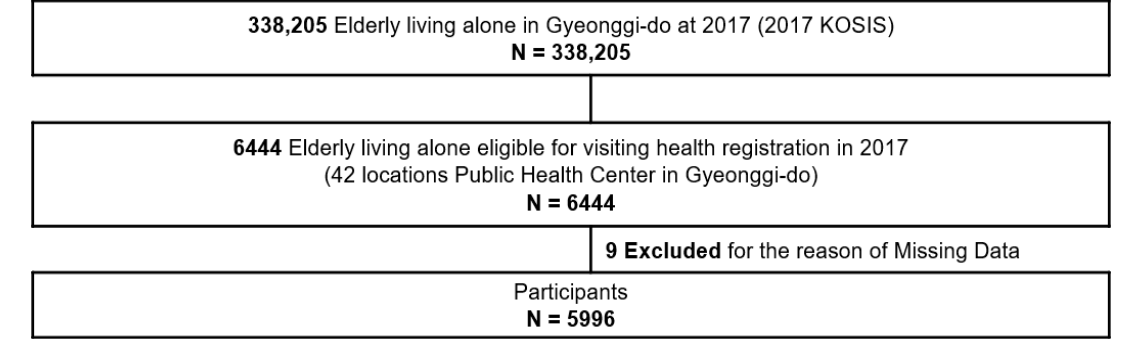
Figure 1. Study population.